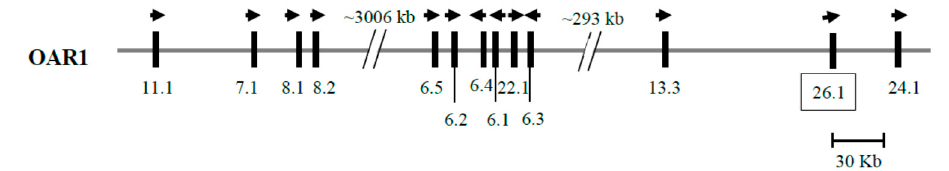
Figure 1. Structure of the sheep chromosome 1 region that contains a sequence similar to human KRTAP26-1 . The newly identified ovine KRTAP26-1 is shown in a box, and twelve previously identified KRTAPs [3,10] on sheep chromosome 1 are also shown. Vertical bars represent the location of different KRTAPs and the arrowheads indicate the direction of transcription. The numbers below the bars indicate the name of the respective keratin-associated protein (KAP) genes (i.e., 11.1 is KRTAP11-1 ). The nucleotide distances refer to NC_019458.